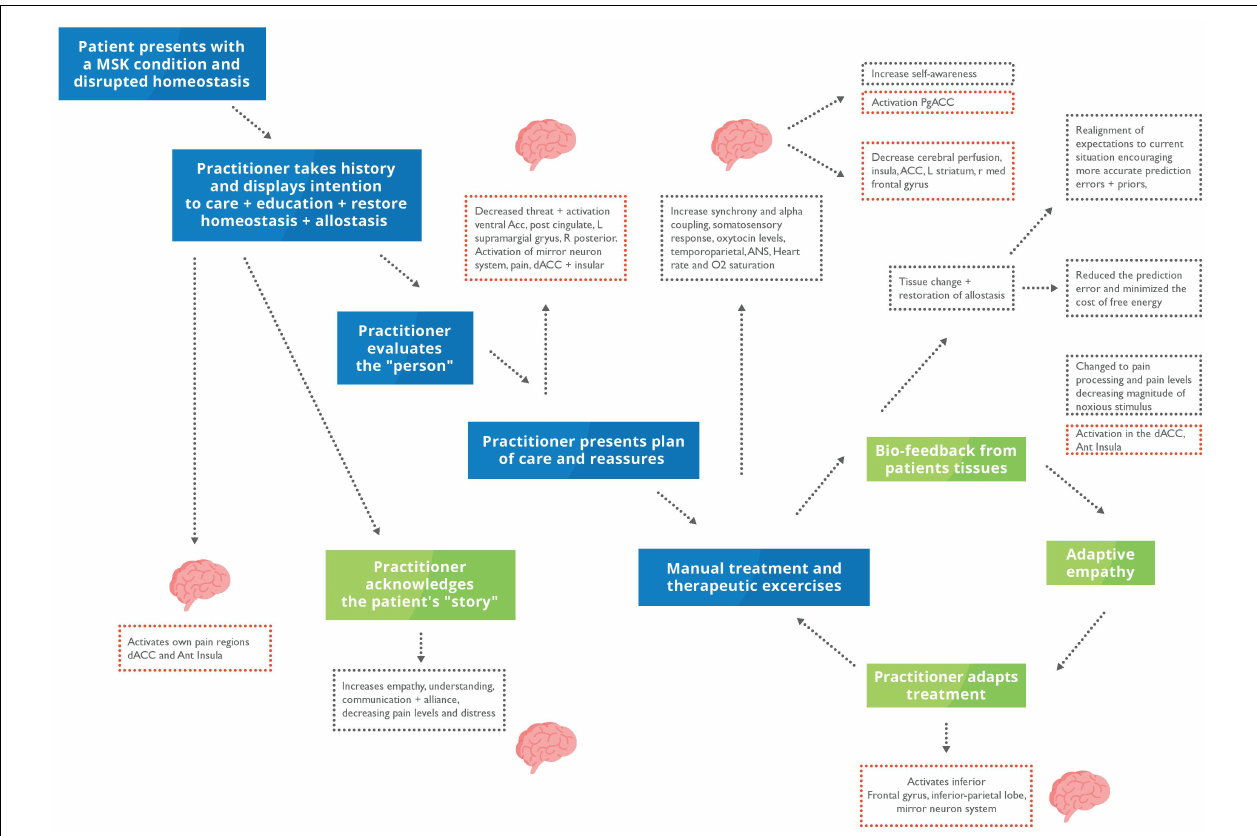
FIGURE 3 | Putative model homoeostatic regulation in musculoskeletal (MSK) care during a clinical encounter. Blue box, clinical presentation and practitioner’s actions; Green box, interoceptive metacognitions; Red dotted box, changes in brain activity; Black dotted box, changes to interoception and mental states. The patient will present with disrupted homoeostasis because of their clinical condition. During a clinical encounter, the HCP will take a case history, examine their patient, and discuss their condition and care plan. The HCP will reassure, educate, understand, acknowledge, and empathise with their patient. We propose that hands-on care which is underpinned by a robust therapeutic alliance and communication can putatively restore homoeostasis through increasing biobehavioural synchrony and active inference – thus updating the patient’s generative